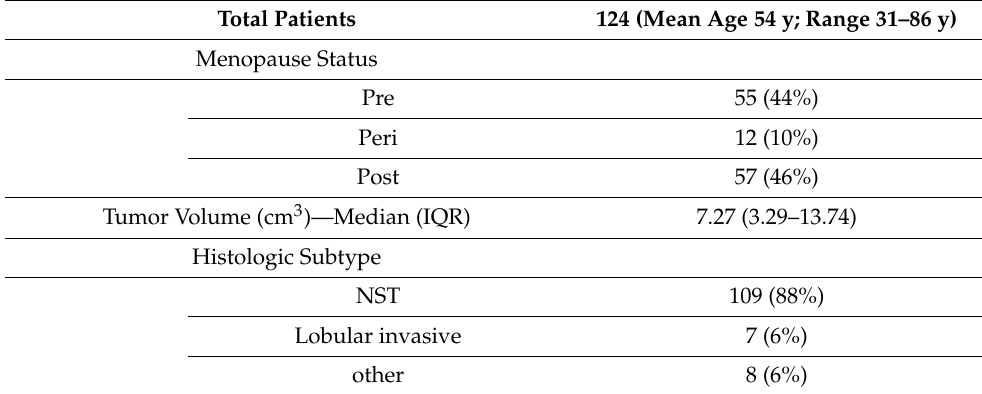
Table 1. Patients